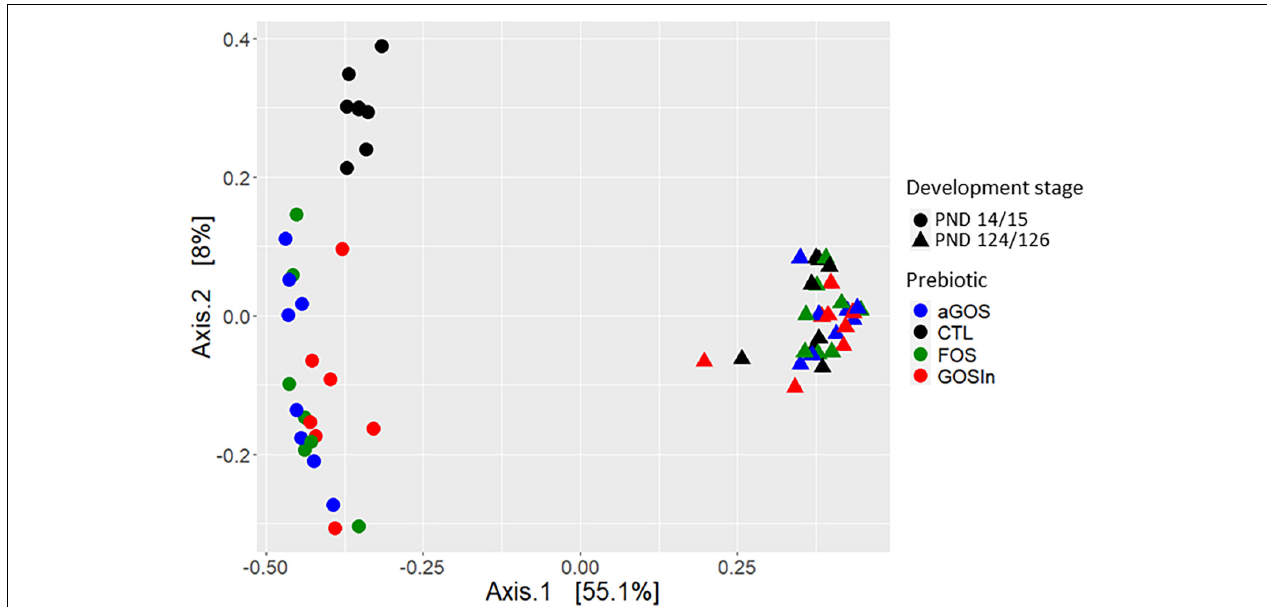
FIGURE 1 | Illustration for the disappearance of the impact of neonatal prebiotic supplementations on caecal bacterial communities in rats: pups supplemented with different prebiotics [alpha Galacto-oligosaccharide, Fructo-oligosaccharides or a mix (9:1) of beta-Galacto-oligosaccharides and inulin] from post natal day 5–14/15 clustered together but did not overlap with pups from the CTL group at the end of the supplementation (PND14/15): they exhibited a clearly distinct microbial community as compared to unsupplemented pups. This was no longer true in adulthood (PND124/126) where all individuals clustered together [multidimensional scaling (MDS) analysis based on dissimilarities measures (Bray–Curtis) calculated from data published by Le Dréan et al.,